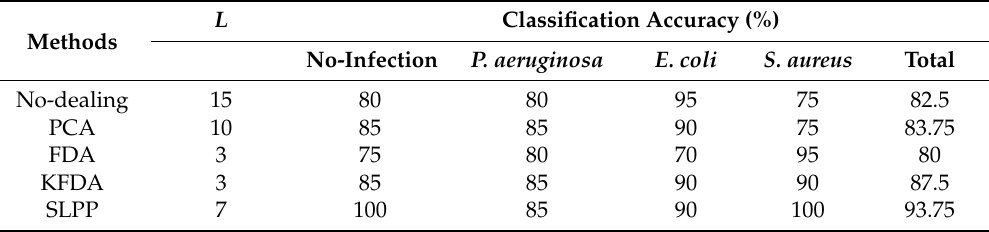
Table 6. Classification results of 80-fold using different processing methods (SVM).